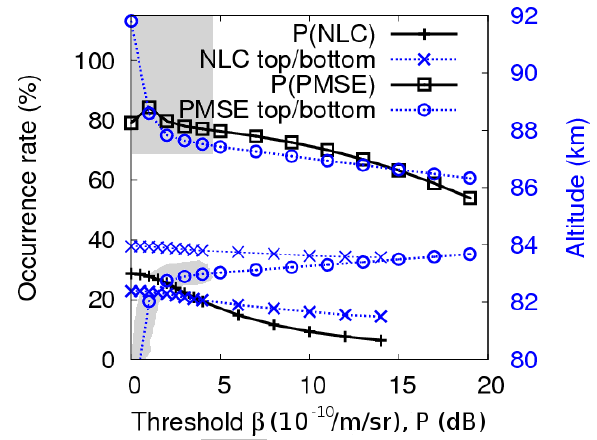
Fig. 5. Dependence of PMSE and NLC occurrence rates (black, left axis) and averaged top and bottom altitudes of PMSE and NLC (blue, right axis) on the threshold P thr or β thr .